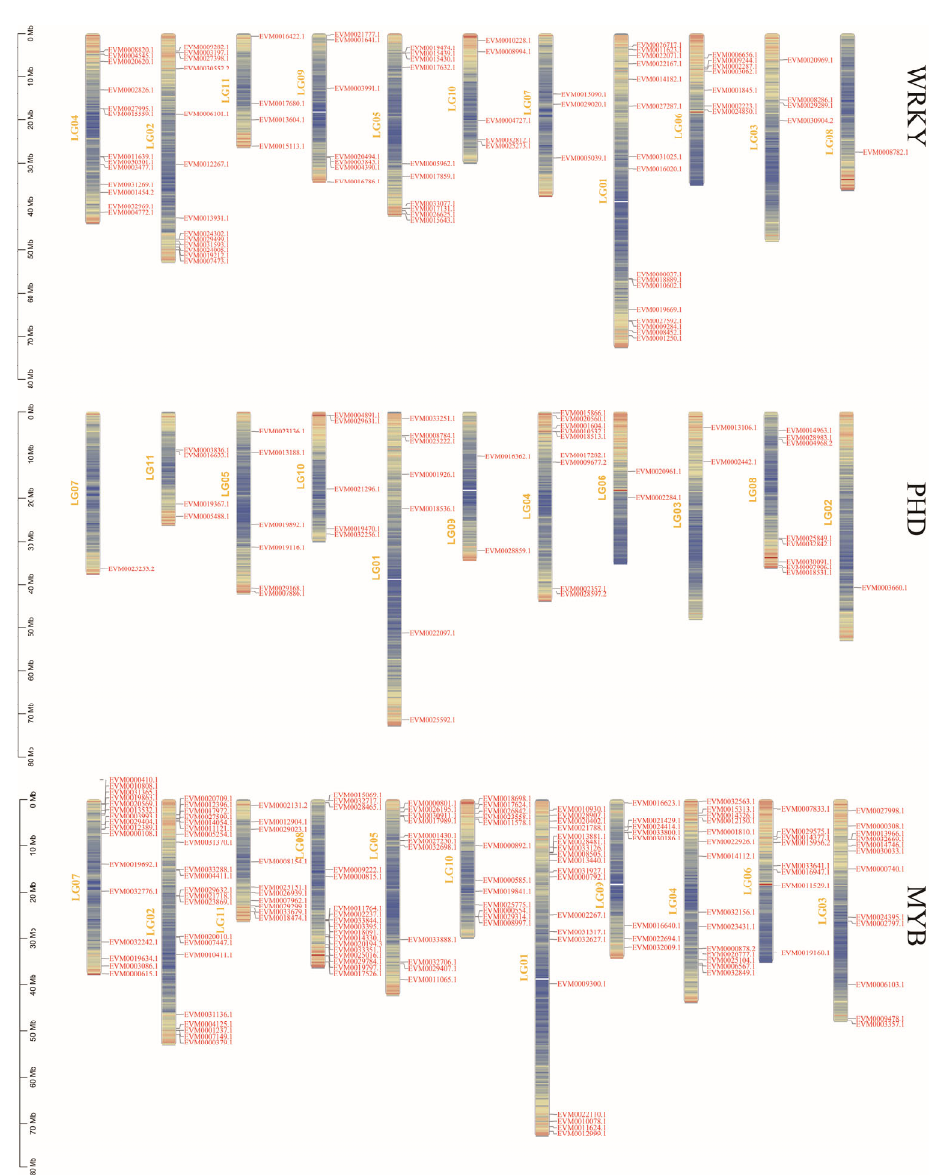
Figure 4. Distribution of three mungbean gene families on 11 chromosomes.